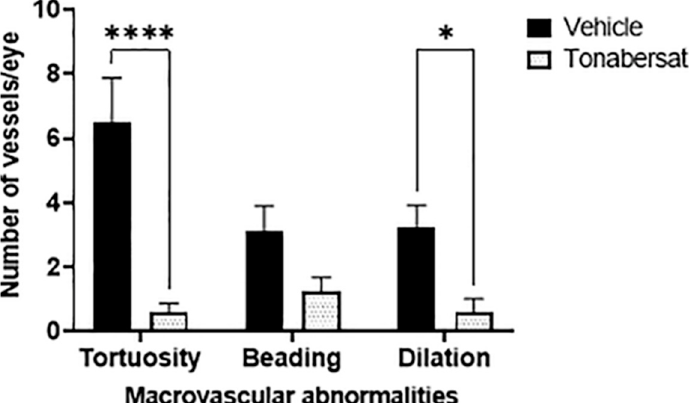
Figure 1. Tonabersat pre-treatment significantly reduced the formation of tortuous and dilated vessels and appeared to reduce the number of beaded vessels (although not reaching statistical significance for the latter). Data are presented as a mean + standard error of the mean (SEM). Statistical analyses were carried out using two-way ANOVA with Sidak’s multiple comparisons test. * p ≤ 0.05, **** p ≤ 0.0001. n = 8–12 eyes per group.